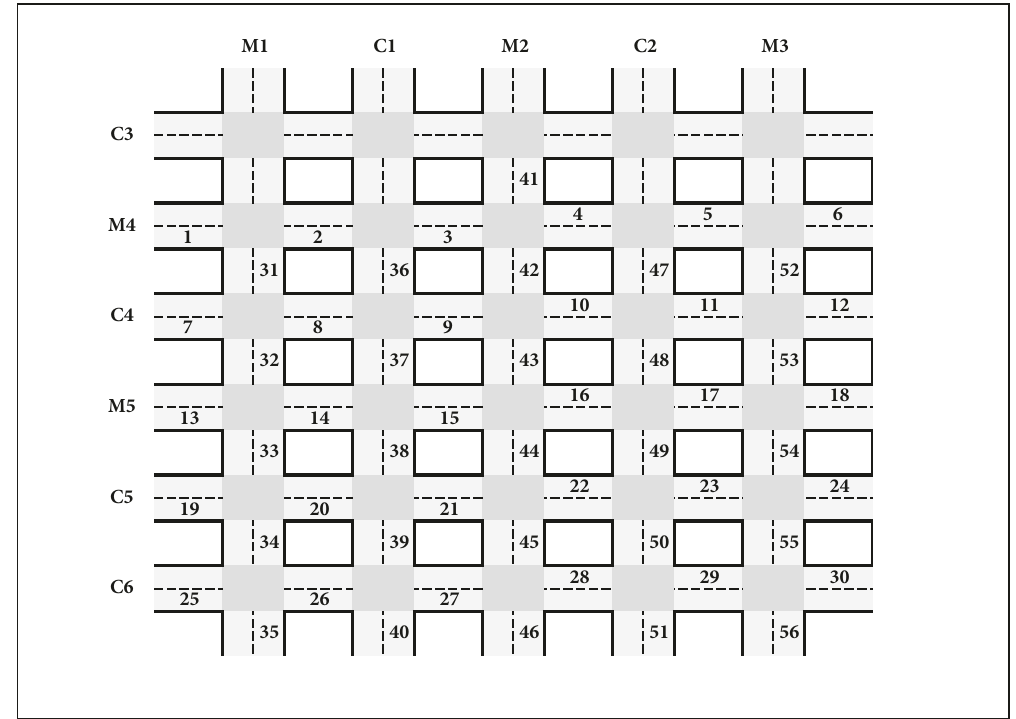
Figure 2: Road section selection based on qualitative analysis.